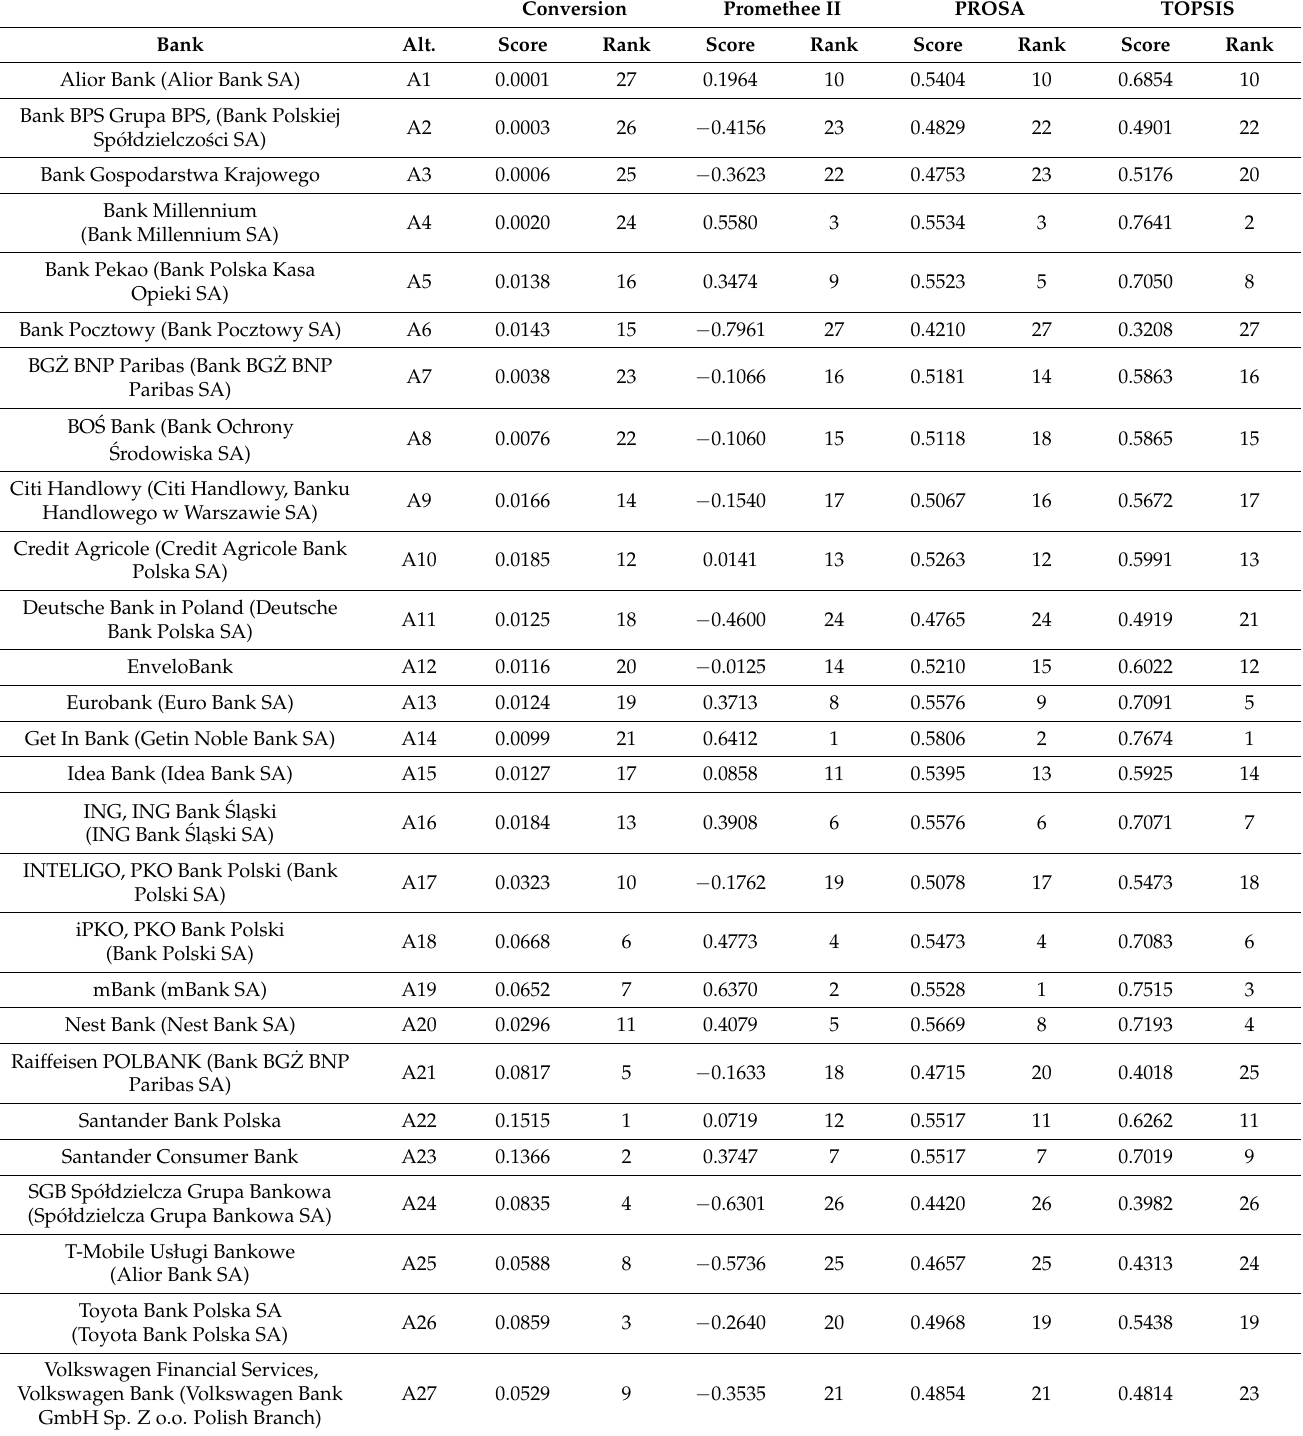
Table 7. The results of calculations of the assessment of banking services using the conversion, Promethee II, PROSA, and TOPSIS methods for 27 banks in Poland in